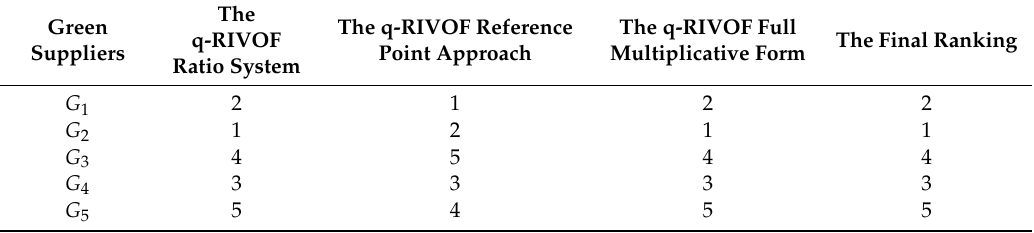
Table 8. Final ranking of green suppliers.